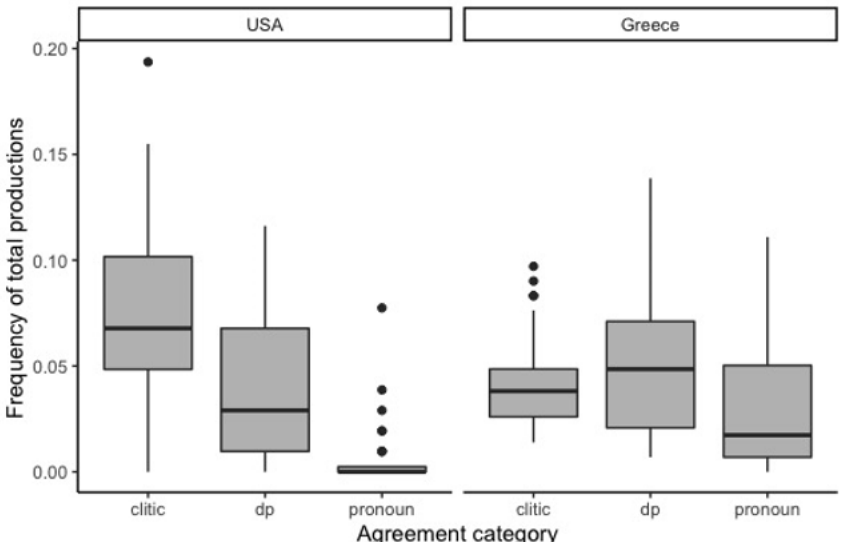
Figure 6. Normalized frequency of total productions for each agreement category (clitic, DP internal, pronoun) per country (USA, Greece) within the adolescents’ group.